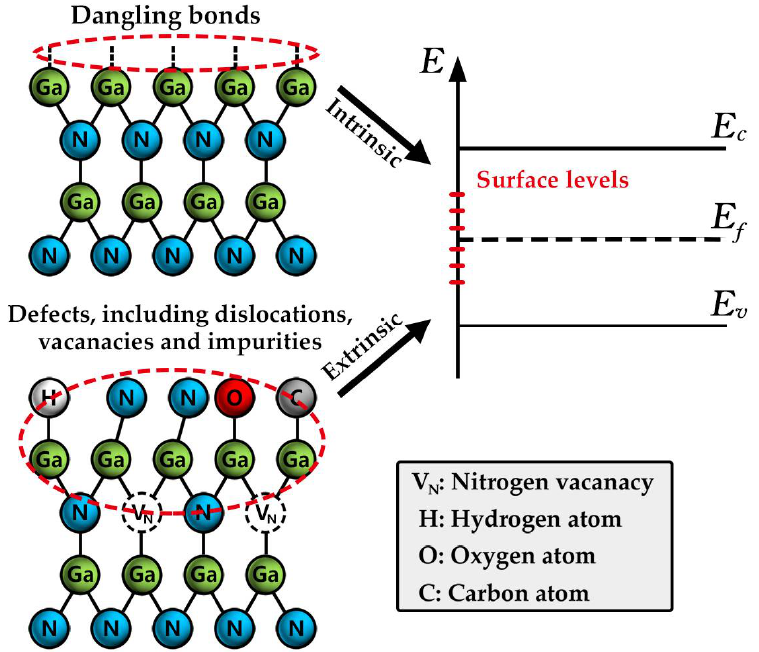
Figure 1. Mechanisms for the generation of intrinsic and extrinsic surface states.